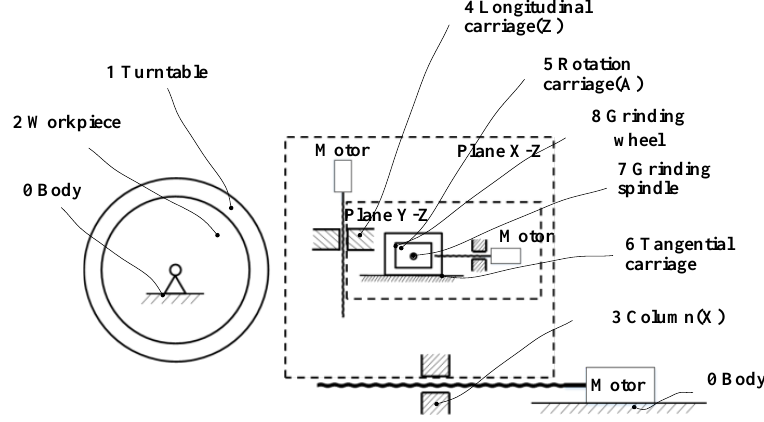
Figure 2. Kinematic chain of the gear grinding system. To investigate the effect of assembly errors on ground tooth surface deviations, the coordinate system transformation with assembly errors was established to describe the spatial relationship between critical components. In Figure 3, S represents the coordinate system. The number in the subscript of S represents the corresponding component in Figure 2, and the small s and d attached to the number represent the stationary coordinate system and the moving coordinate system of the same component, respectively. S a , S b , S c , and S d are auxiliary coordinate systems. The assembly errors of the gear grinding system are shown in Table 1.